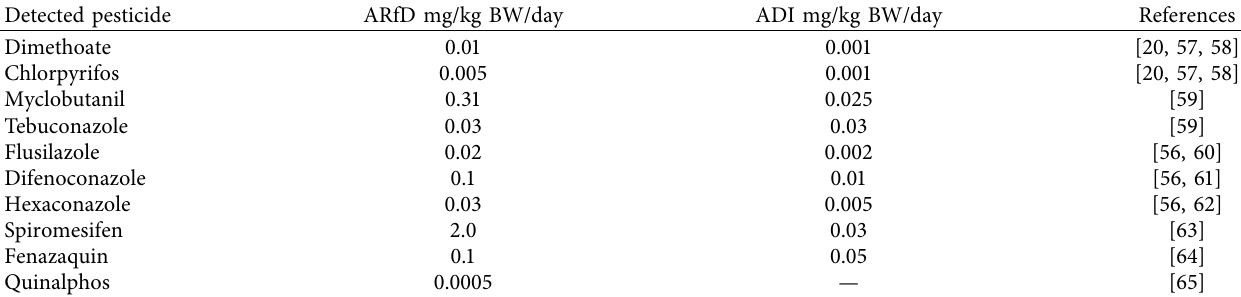
Table 3: Detected pesticides with ARfD and ADI